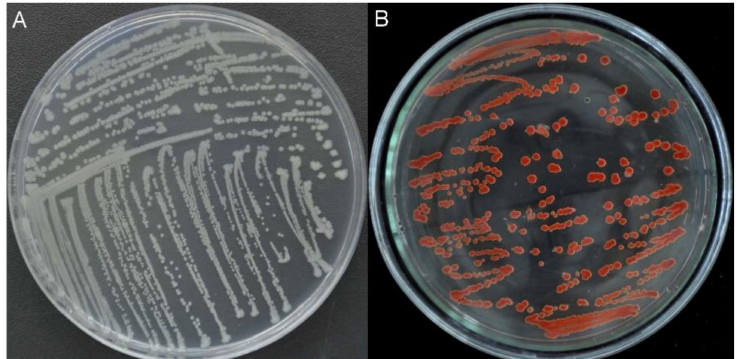
Figure 1. Growth of strain Se03 on YEP (Yeast Extract Peptone) agar plates in absence ( A ) and presence ( B ) of 5.0 mM selenite. The red colony color indicates selenite reduction and the formation of elemental selenium (Se 0 ).